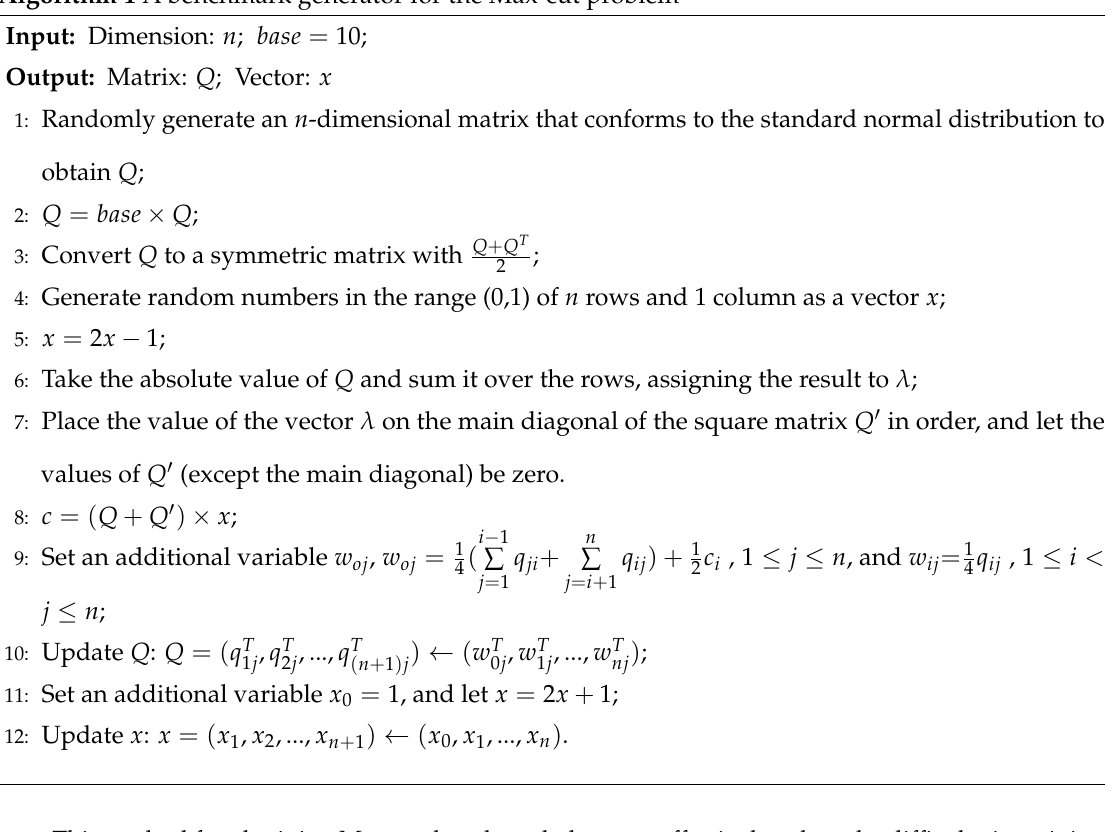
Algorithm 1 A benchmark generator for the Max-cut